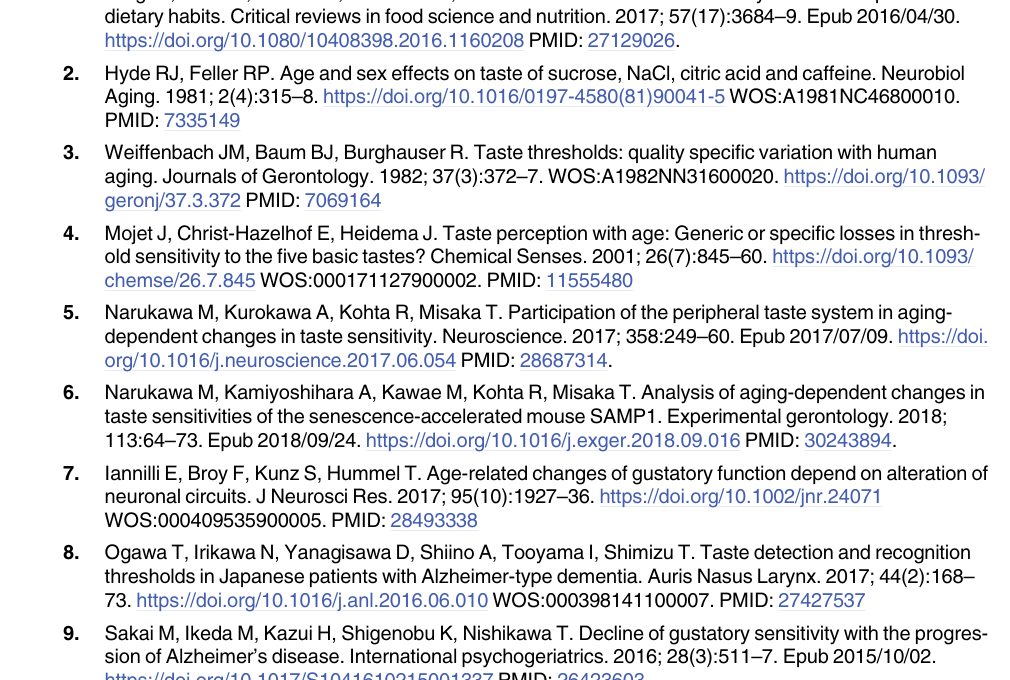
S4 Fig. qPCR data from the hippocampus of 7 and 80-weeks-old